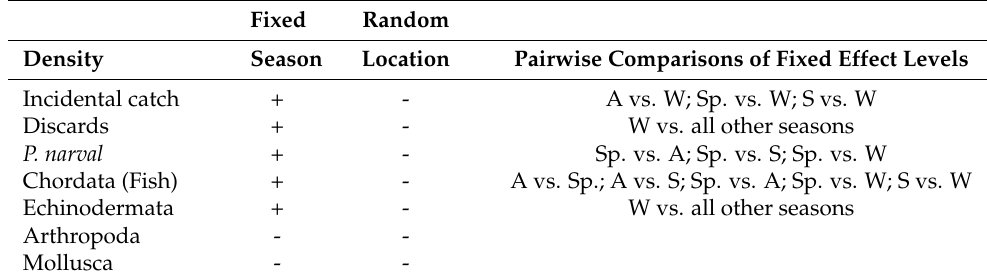
Table 4. Summary of the linear mixed model effects based on the species’ densities per category, with season (fixed factor) and location (random factor) as